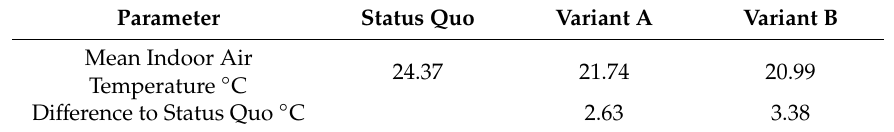
Table 2. Indoor air temperature for Elief Playhouse variants on an idealized hot summer day (21.07).